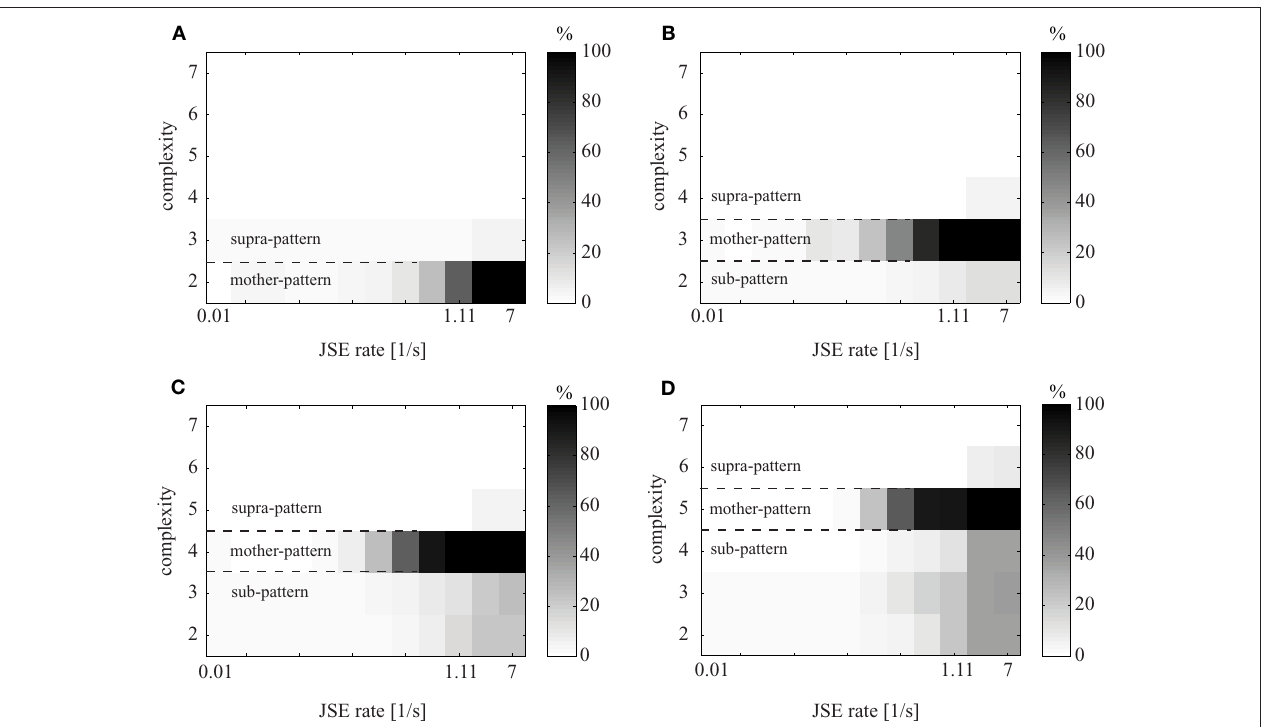
of higher complexities. The excess rate of JSEs in one condition, which corresponds to the mother-pattern, is given on the x -axis. The standard parameters were chosen as T = 50 trials, background spike rate r = 15 spikes/s, S = 20 surrogates, and h = 5. (A–D) Shows the variations of mother-patterns with